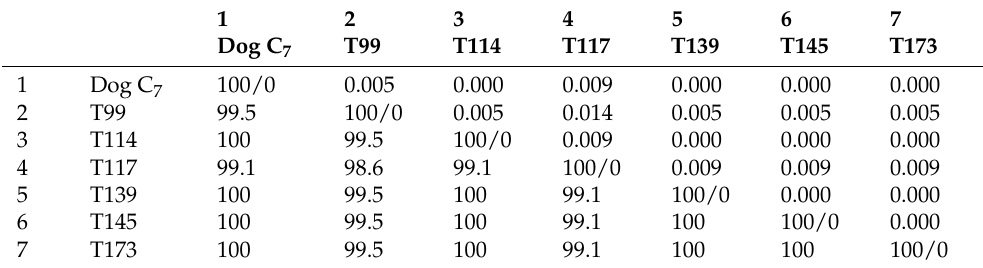
Table 4. Homology and genetic distance between L RNA sequence (201 nt) from TOSV detected in females P. perniciosus fed on dog C 7 and the six TOSV sequences detected in field-collected